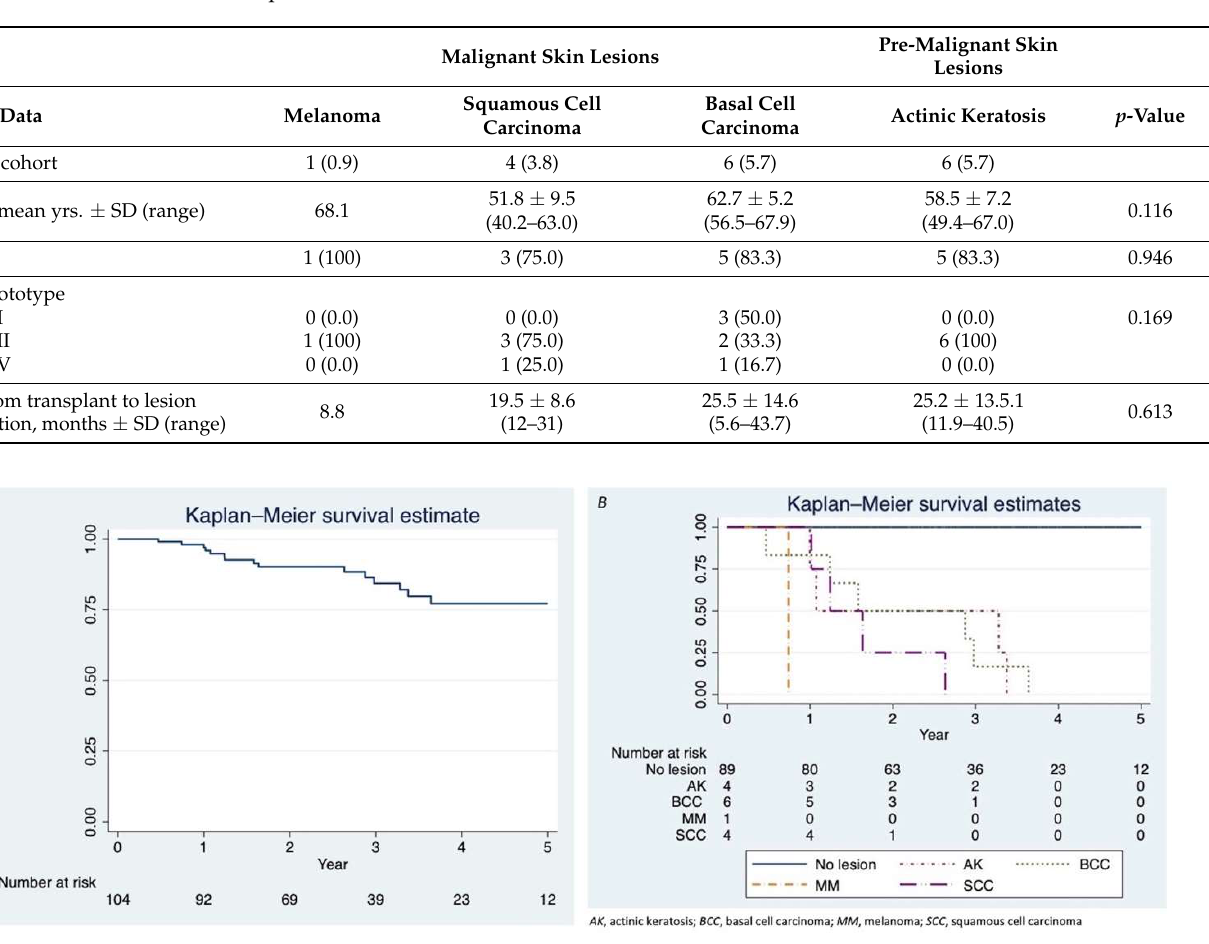
Table 2. Duration of follow-up and patient characteristics. Only patients who developed cancerous or precancerous skin lesions are included in this table.